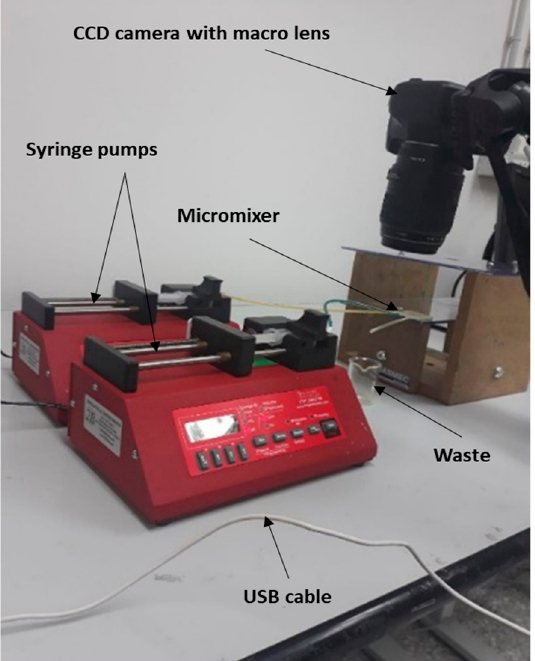
Figure 4. Experimental setup and detection system for testing our microfluidic systems.